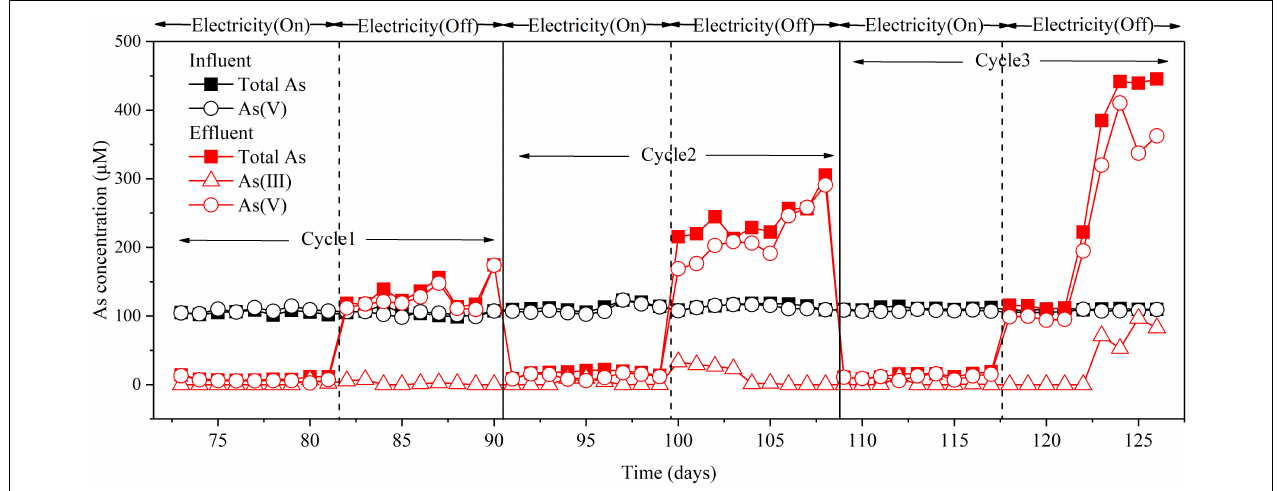
FIGURE 3 | Effect of electricity on As(V) removal in the BES cathode chamber. Experimental conditions: influent [As(V)] = 100 µ M, (Na 2 SO 4 ) = 3.3 mM, I cell = 30 mA. “On” indicates the I cell was applied; “Off” indicates the I cell was absent. Cycle 1, Cycle 2, and Cycle 3 represent three replicates of electricity